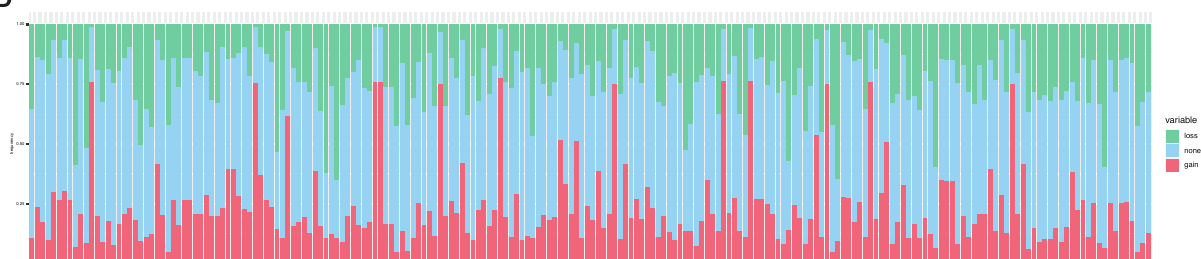
Figure 4. SNV and CNV of phagocytic factors. ( A ) Mutation rate top 20 phagocytic factors, ( B ) chromosome distribution of phagocytic factors according to different sources, marked in the center of circles, ( C ) the CNV of the mutant phagocytic factor, and ( D ) phagocytosis of